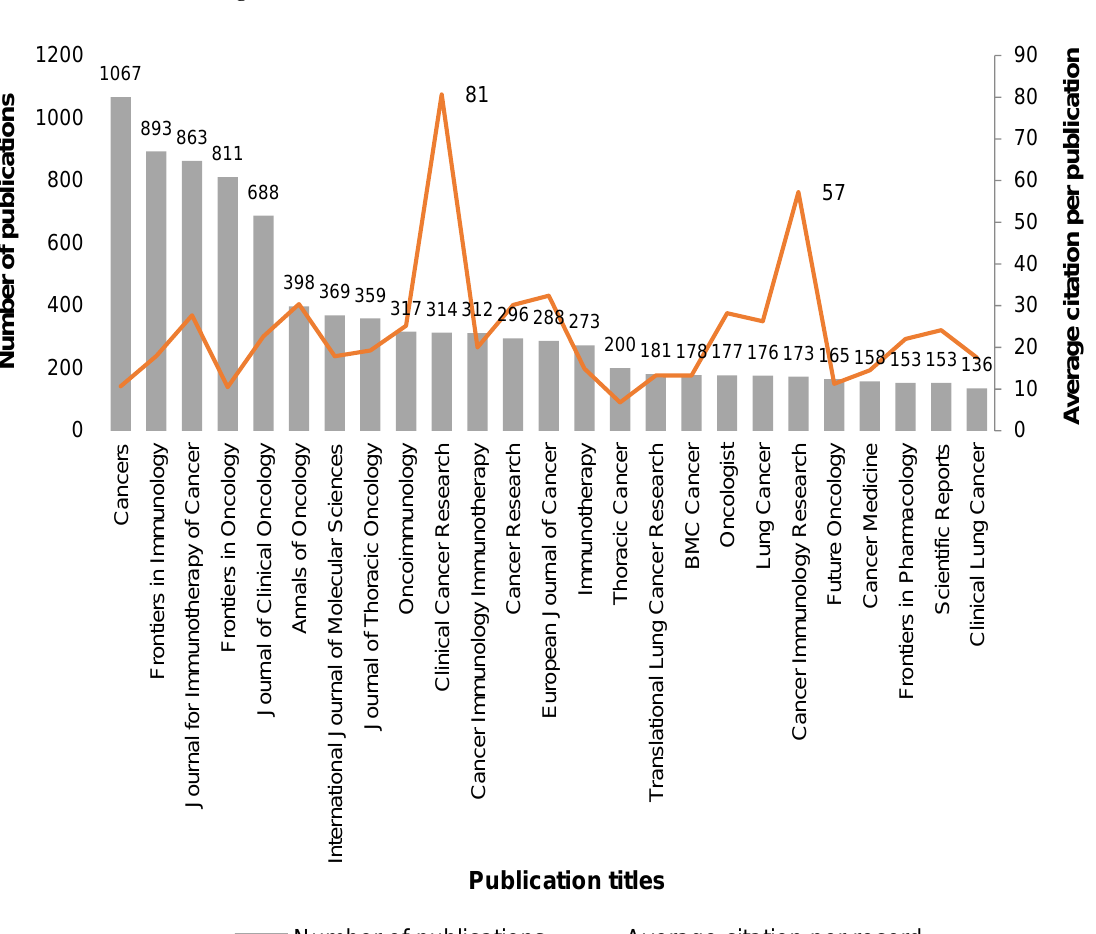
Figure 2. Analysis of the 25 selected journals reporting ICIs in cancer topics, by number of records